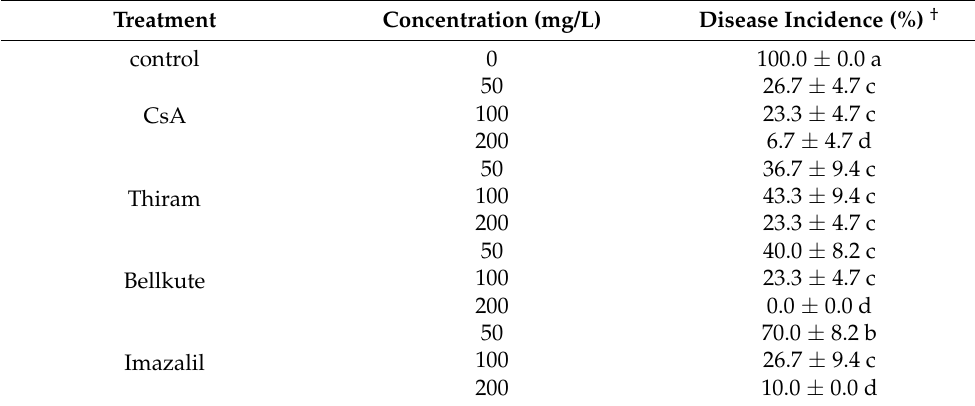
Table 2. The disease incidences of cyclosporin A (CsA) against A. niger on grapes. Treatment Concentration (mg/L) Disease Incidence (%) † control 0 100.0 ± 0.0